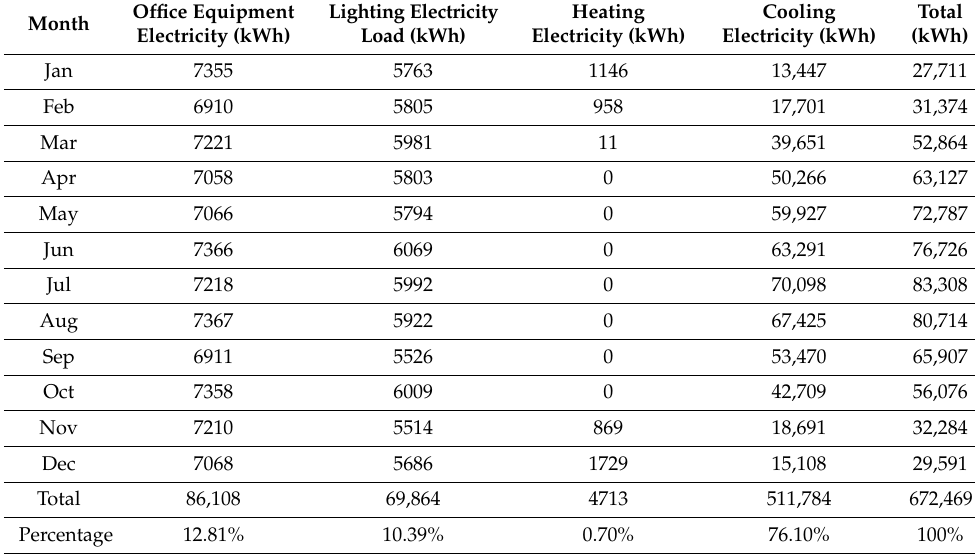
Table 3. Monthly energy end-use distribution for a simulated model for ADF